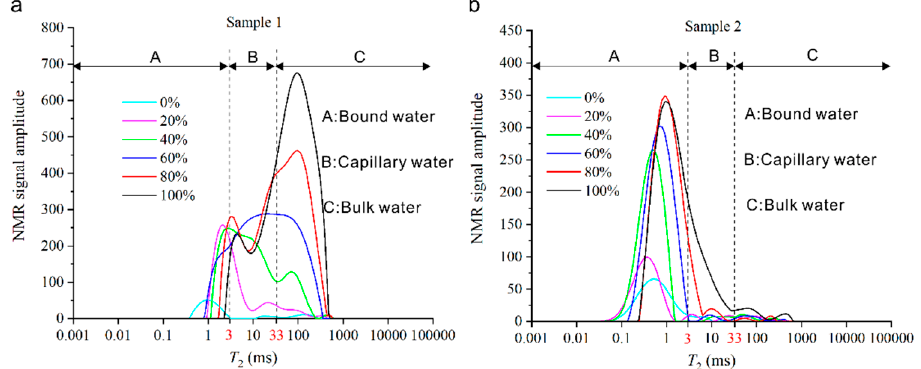
Figure 4. Variation in T 2 spectra with sandstone saturation in samples ( a ) 1 and ( b ) 2.